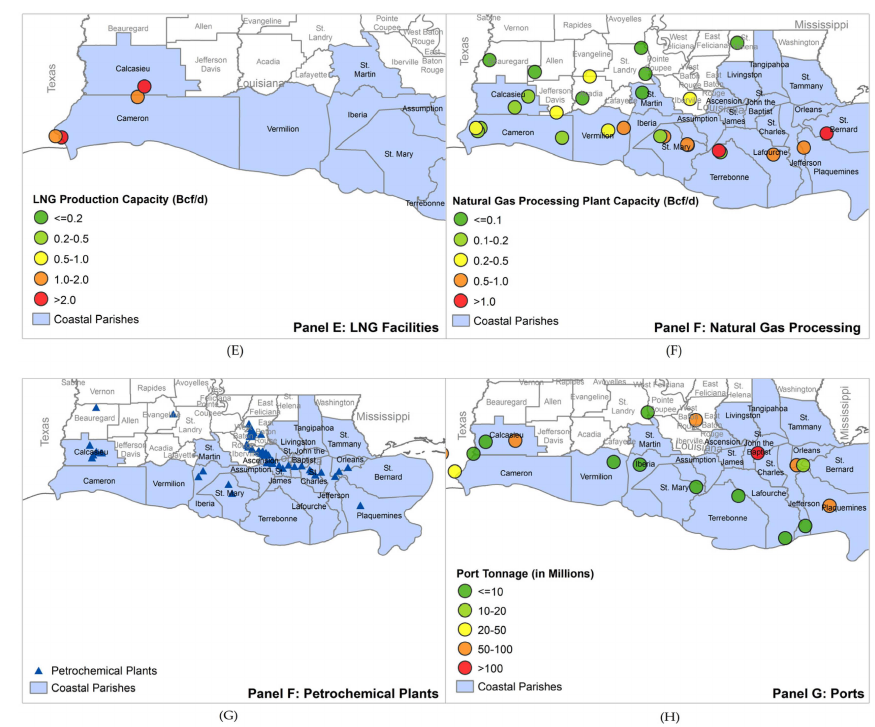
Figure 3. Critical energy infrastructure located in coastal Louisiana: ( A ) Refineries; ( B ) Oil and gas pipelines; ( C ) Electric generators; ( D ) Natural gas storage; ( E ) LNG facilities; ( F ) Natural gas processing plants; ( G ) Petrochemical plants; and ( H ) Ports.